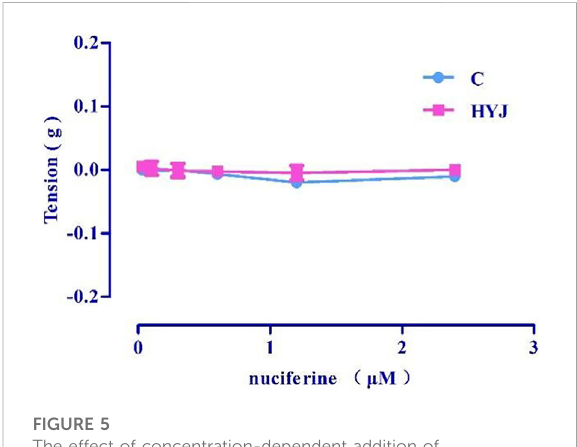
The effect of concentration-dependent addition of nuciferineonbloodvessels.Thedataareexpressedasthemeans± SD of 6 – 8 rats ( n = 6 – 8).